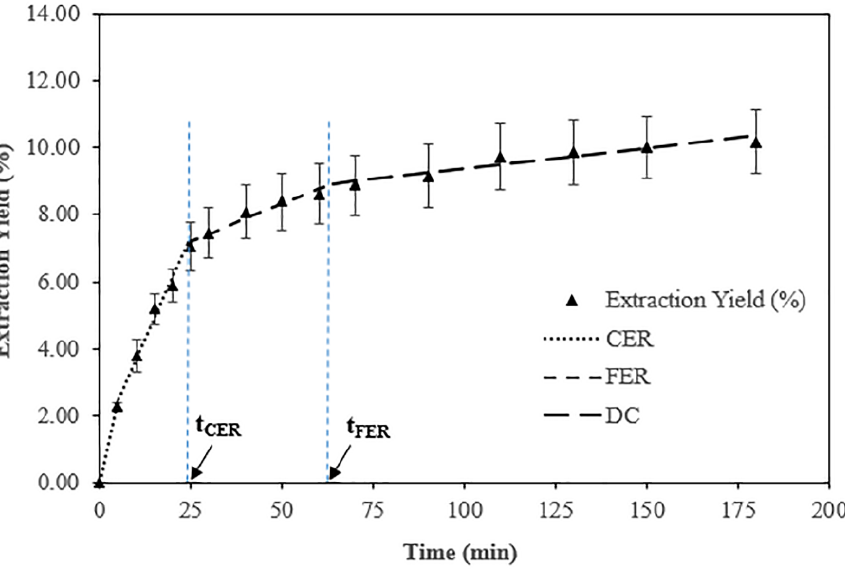
Figure 2. Overall extraction curves (OEC) of Coccomyxa onubensis by SFE at P = 40 MPa, T = 50 °C, CO 2 +ethanol (75:25 v / v ) flow rate (3.1 g/min). CO 2 +ethanol (75:25 v / v ) flow rate (3.1